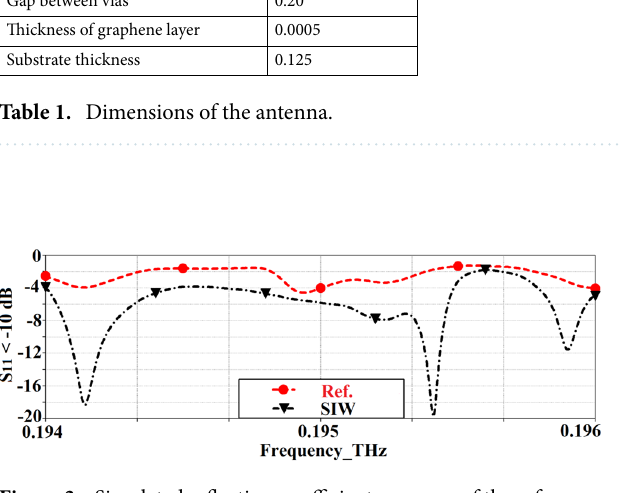
Figure 3. Simulated reflection-coefficient response of the reference and SIW-loaded patch